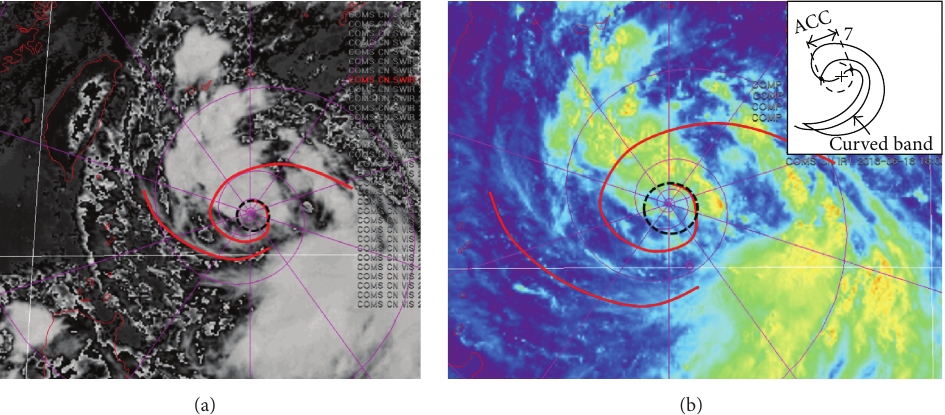
Figure 5: The PIs (circles) and the estimated centers (dots) of Typhoon LEEPI (1304) using shortwave infrared (a) and visible imagery (b) of satellite “COMS,” at the same time as Figure 4. The schematic diagram on the top right shows estimation of a TC center and ACC (or a range similar to PI) of a band pattern cloud and was excerpted from the